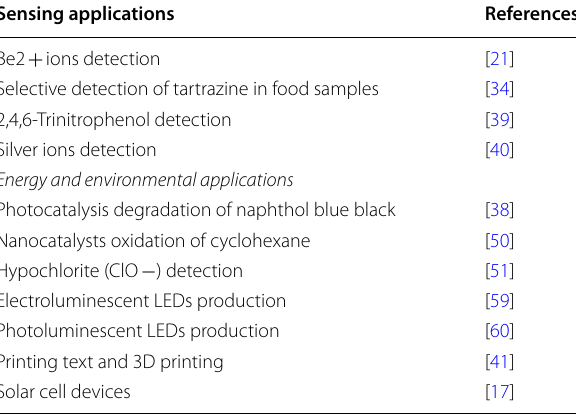
Table 1 Examples of common usable applications of CDs Sensing